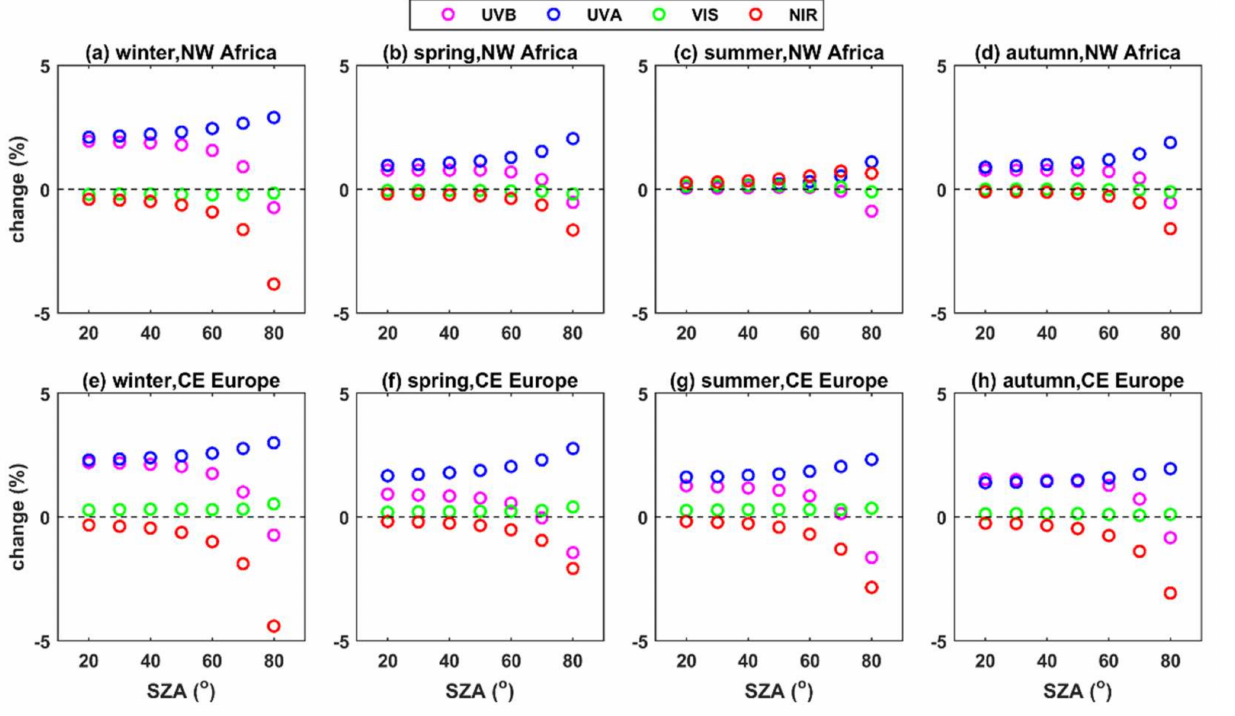
Figure 12. Change (in %) in the simulated UDI at TOA due to the use of the LIVAS profiles instead of the default libRadtran